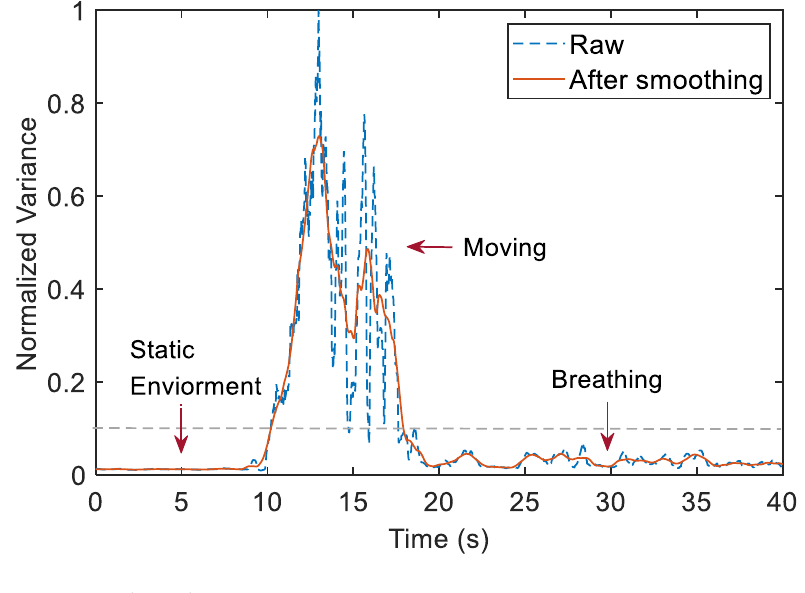
Figure 5. Breathing detection.